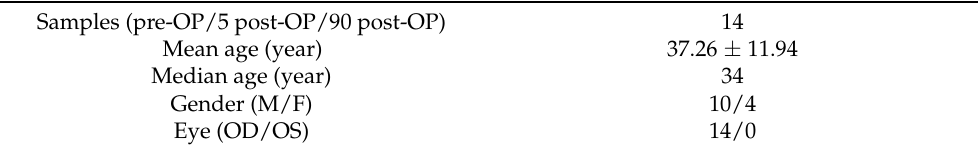
Table 1. Clinical patient data for all groups. Abbreviations: M = male, F = female; OD = right eye; OS = left